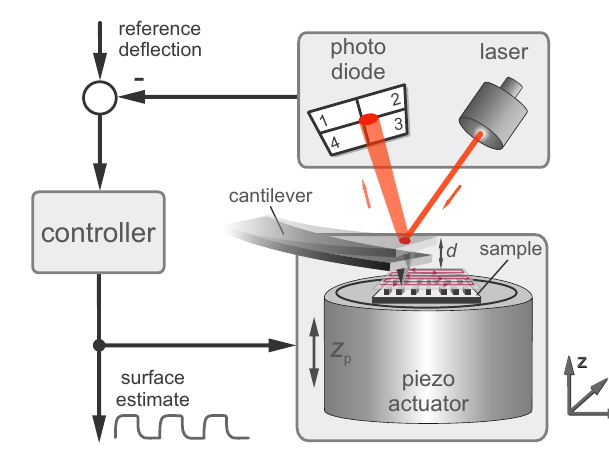
Figure 3. Basic principle of an atomic force microscope in a closed- loop configuration (constant force mode).